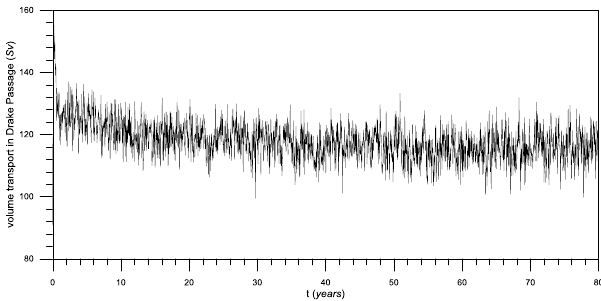
Fig. 4. Volume transport across the Drake